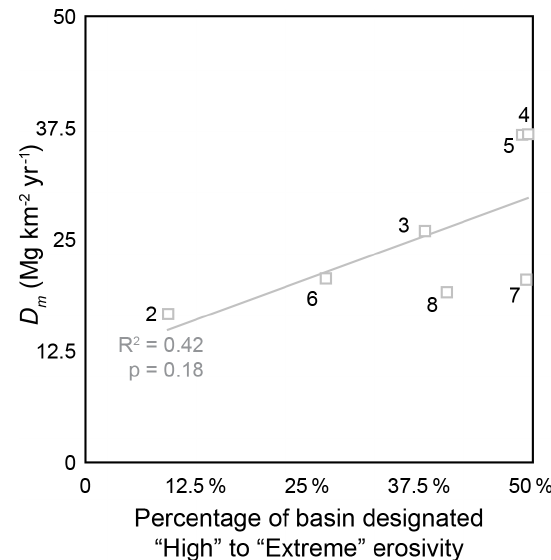
Figure 9. 10 Be m / 9 Be reac -based denudation rates, D m (gray squares), from tributary basins measured at George River are related to the percentage of the basin that is classified as “High,” “Very High,” or “Extreme” erosivity (Kidd et al., 2014, 2015), though this relationship is not significant ( p = 0.18). The basins with the highest denudation rates are those with histories of intensive min- ing and/or recent forestry, both of which disturb